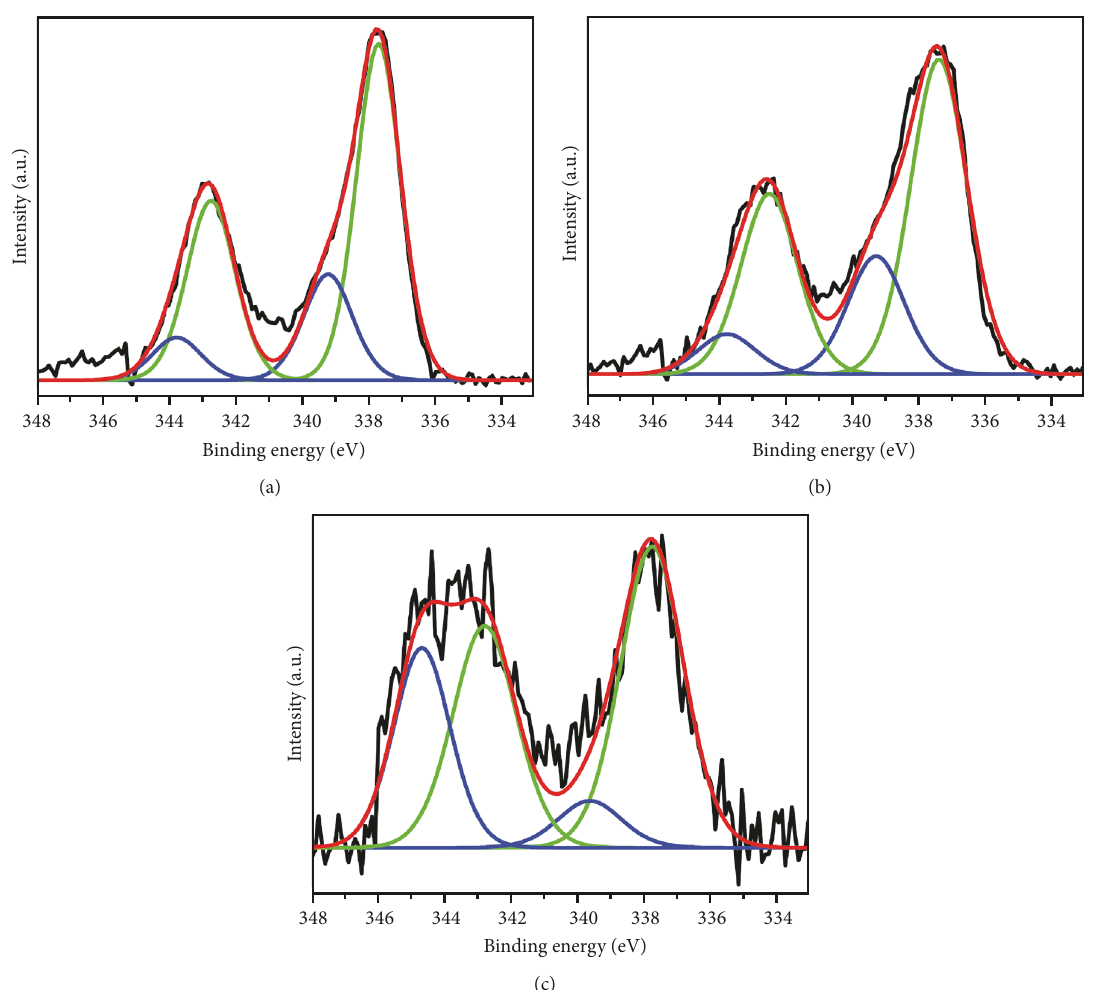
Figure6:Pd3dXPSprofilesofthePd-impregnatedceriacatalysts.(a)3Pd-CeO2-T-Cl,(b)3Pd-CeO2-T-N,and(c)3Pd-CeO2-B-N.Thegreen and blue lines represent the decomposed spectra which could be assigned to the oxidized Pd species of Pd 2+ and Pd 𝛿+ ( 𝛿 > 2), respectively. The red line represents the combination of all decomposed spectra of Pd